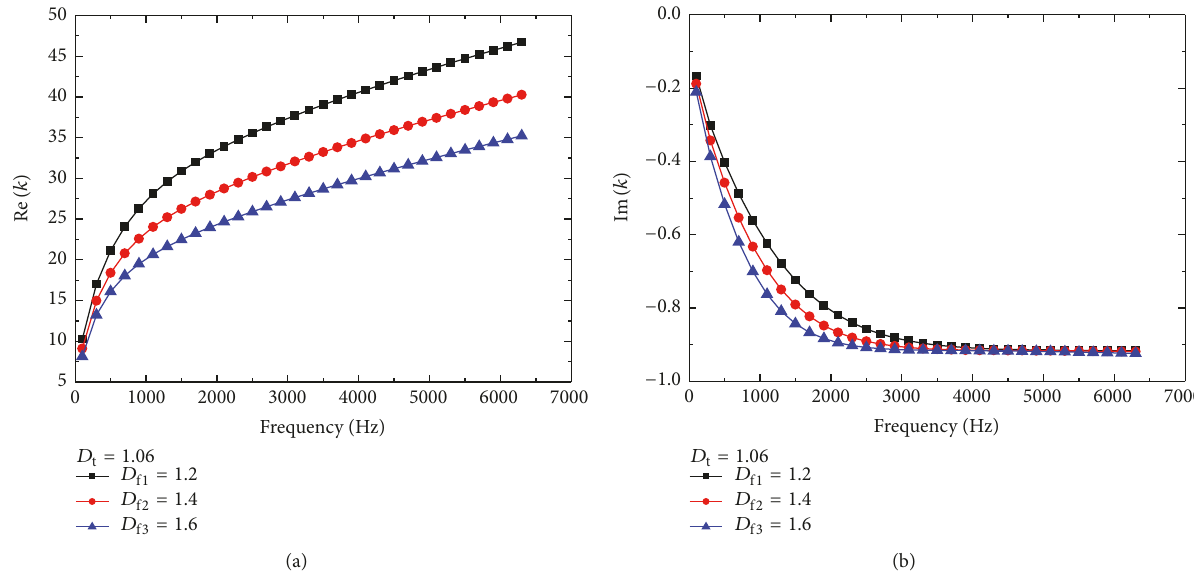
Figure 18: Predictions of the complex wave number 𝑘 with different pore area fractal dimensions. (a) The real part of 𝑘 . (b) The imaginary part of 𝑘